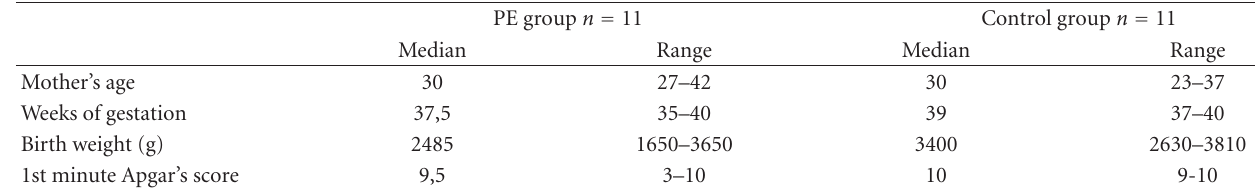
Table 1: The characteristics of patients included into the